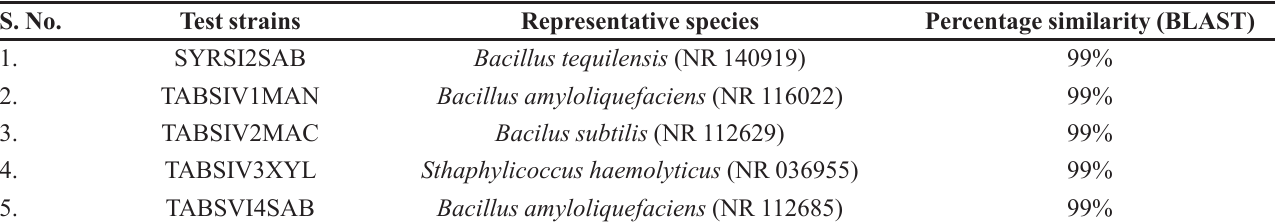
TABLE I - Percentage similarity of tested strains against representative species in BLAST search S.